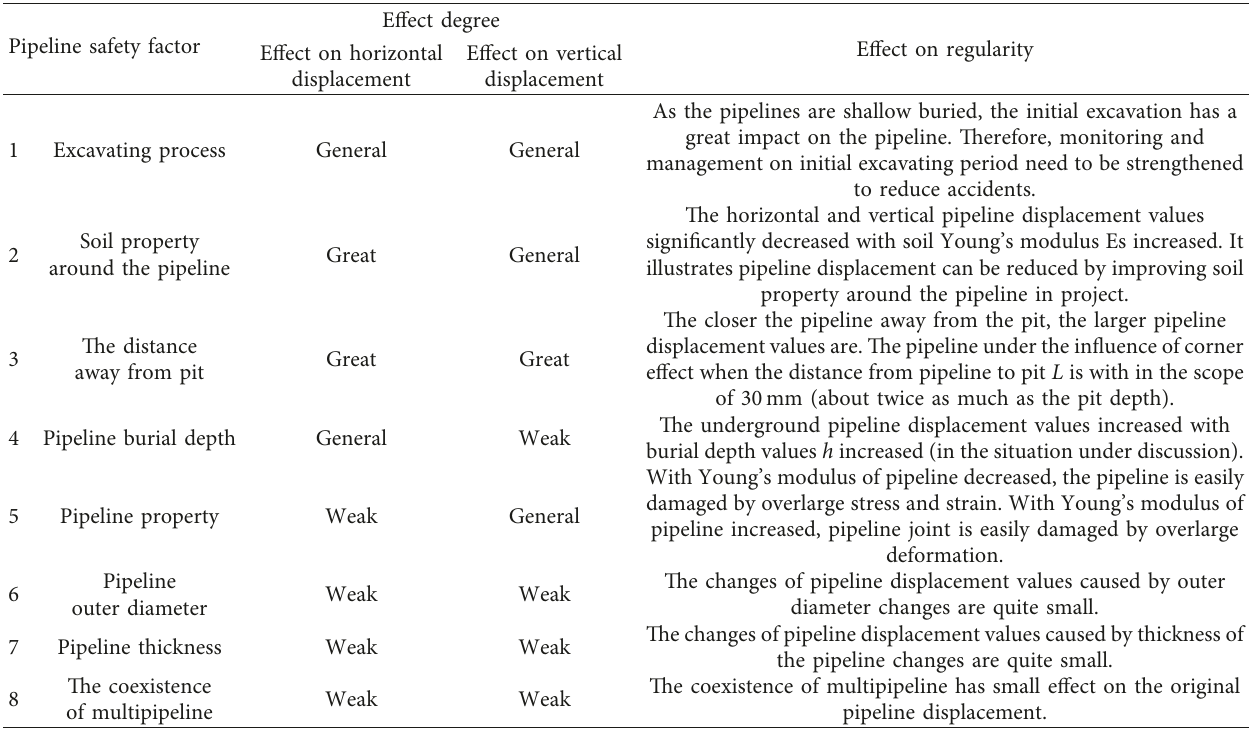
Figure 10: The effect on pipeline of different strut positions and diameters. (a) The pipeline displacement of different strut diameters in strut position 1. (b) The pipeline displacement of different strut diameters in strut position 2. Table 2: Summary of pipeline safety factors in the FE